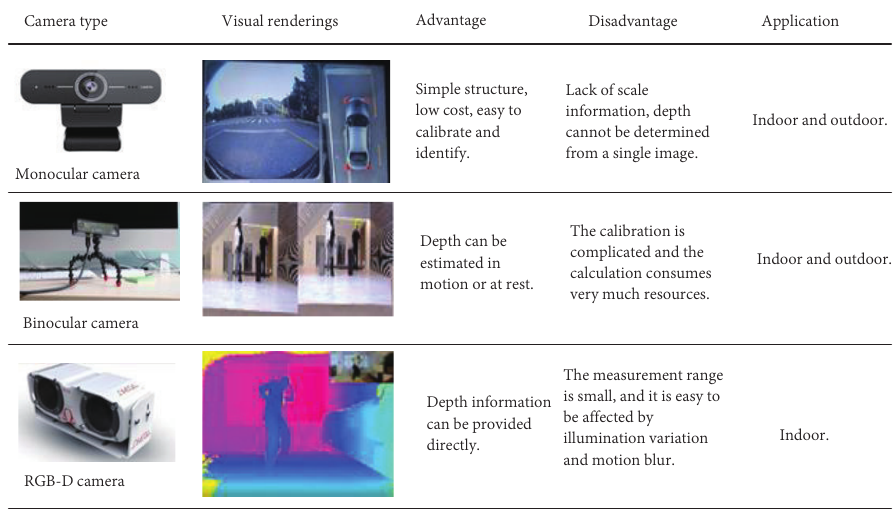
Figure 3. The main sensors used in SLAM, and their advantages, disadvantages, and